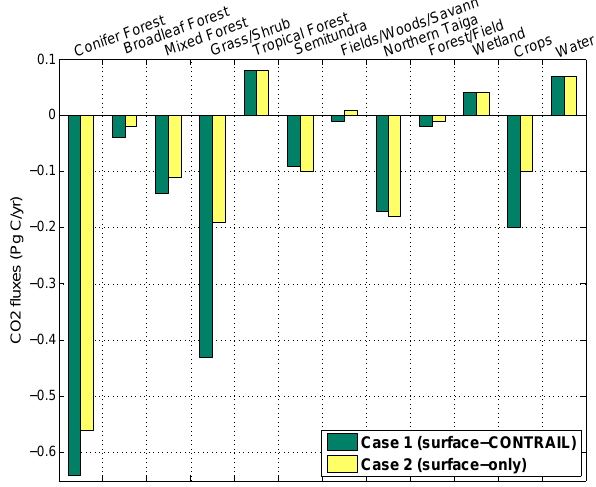
Figure 4. Fluxes per ecoregion in Asia averaged over the period 2006–2010 in Cases 1 and 2 (in PgCyr − 1 )